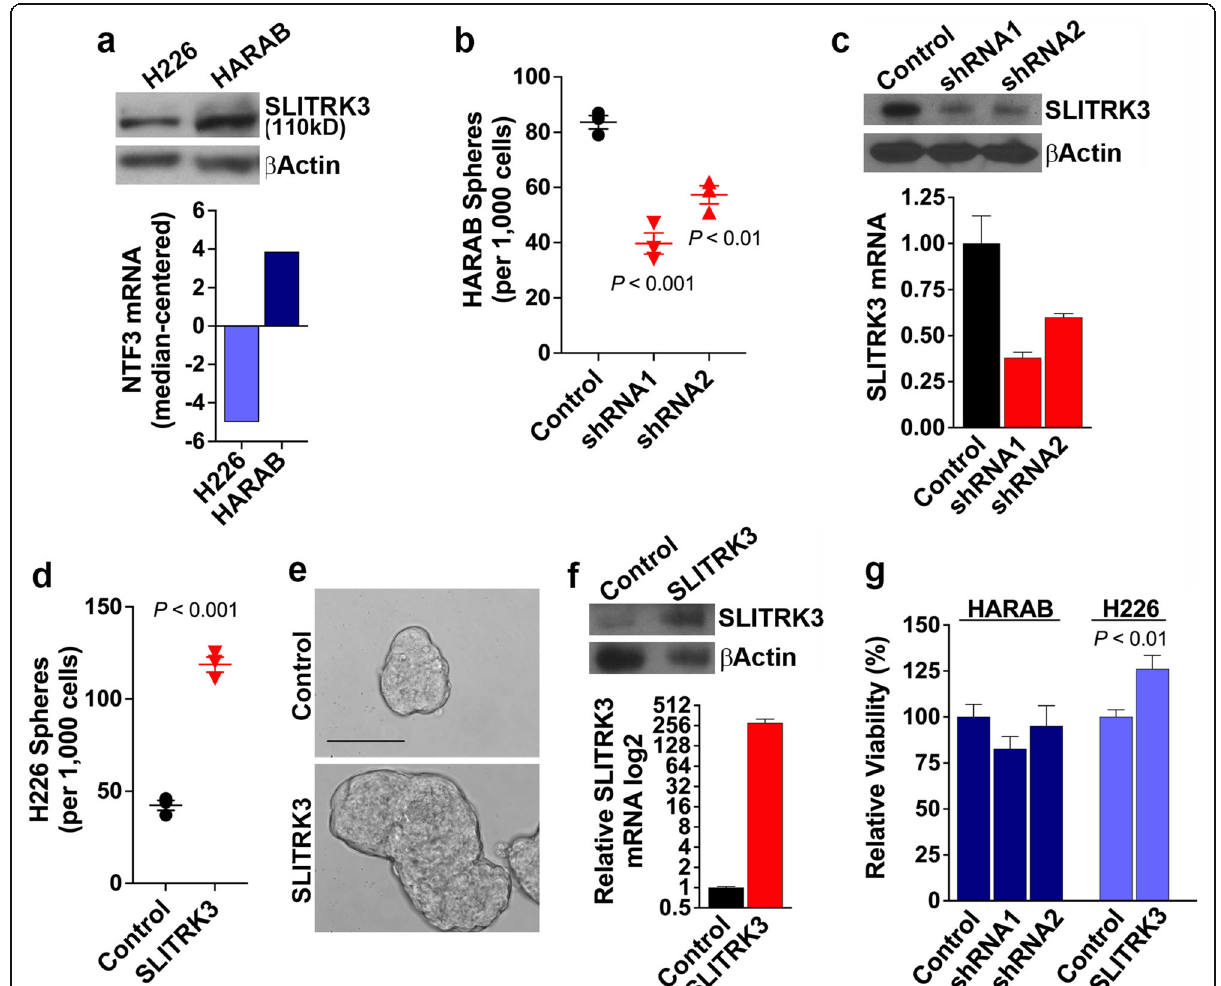
Fig. 2 Effect on sphere-forming CSCs due to stably modifying SLITRK3 levels in LUSC cell lines. (a ) Western blot analysis and RNA-sequencing data (normalized, log2, median-centered) displaying relative SLITRK3 levels in HARAB cells (SLITRK3-amplified) and H226 cells (SLITRK3-diploid). ( b ) Results of sphere formation assays performed with HARAB cells following stable knockdown of SLITRK3 by shRNA vectors (shRNA1 and shRNA2), relative to a nonsilencing control vector. ( c ) Western blot and qRT-PCR analyses of protein and mRNA levels, respectively, confirmed SLITRK3 knockdown in HARAB cells. (d) Results of sphere formation assays performed with H226 cells expressing a GFP control transgene and H226 cells stably overexpressing SLITRK3. Lines, standard error of the mean (SEM). ( e ) Representative images of spheres from GFP-expressing (control) and SLITRK3 overexpressing H226 cells. 40x magnification, Bar=100 μ m. (f) Western blot and qRT-PCR analyses of protein and mRNA levels, respectively, confirmed SLITRK3 overexpression in H226 cells. (g) Results of 3-day cell proliferation assays performed under serum-containing, attached culture conditions. HARAB cells with SLITRK3 knockdown were compared to non-silencing control cells and H226 cells overexpressing SLITRK3 were compared to GFP-expressing control cells. Bars,